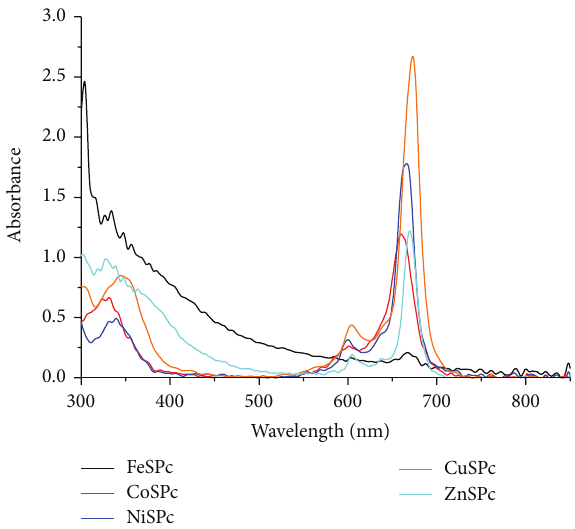
Figure 4: Absorption spectra of sulfonated phthalocyanine metals in DMF (2 × 10 −5 M).